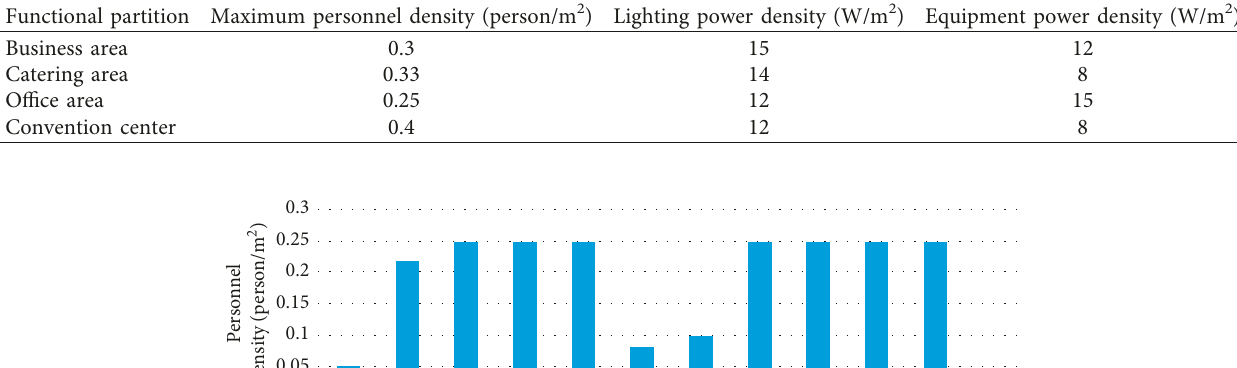
Table 3: System operation arrangement.